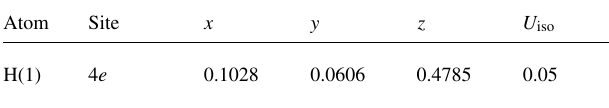
Table 2. Atomic coordinates and displacement parameters (in Å 2 )